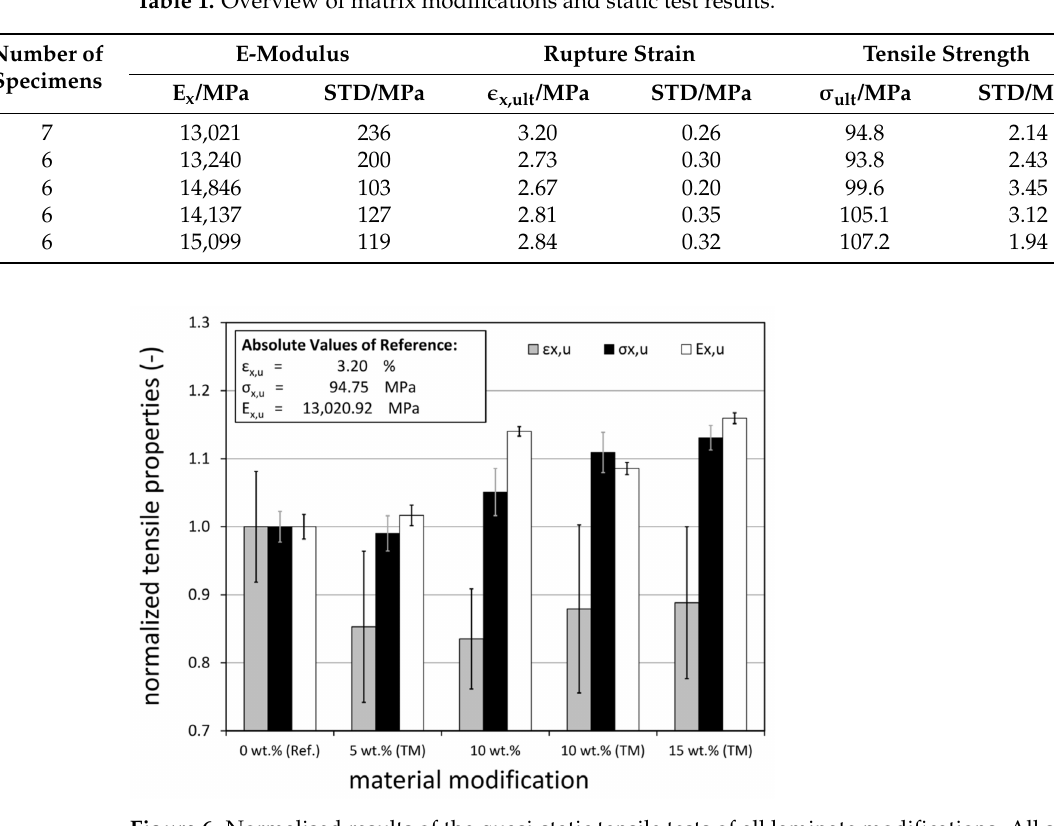
Figure 6. Normalised results of the quasi-static tensile tests of all laminate modifications. All strains to rupture, ultimate stresses and elastic moduli constitute average results of at least six